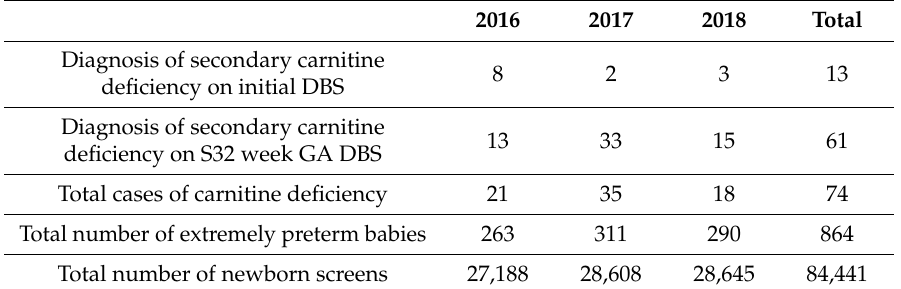
Table 1. Carnitine deficiency cases diagnosed on newborn screening (NBS) during a three-year